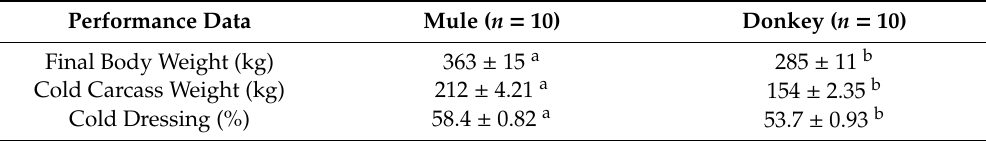
Table 1. Mule and donkey carcass characteristics (means ±